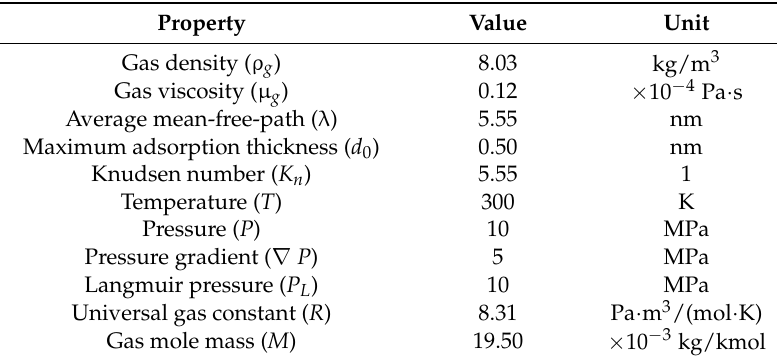
Table 2. Properties of gas flow in shale